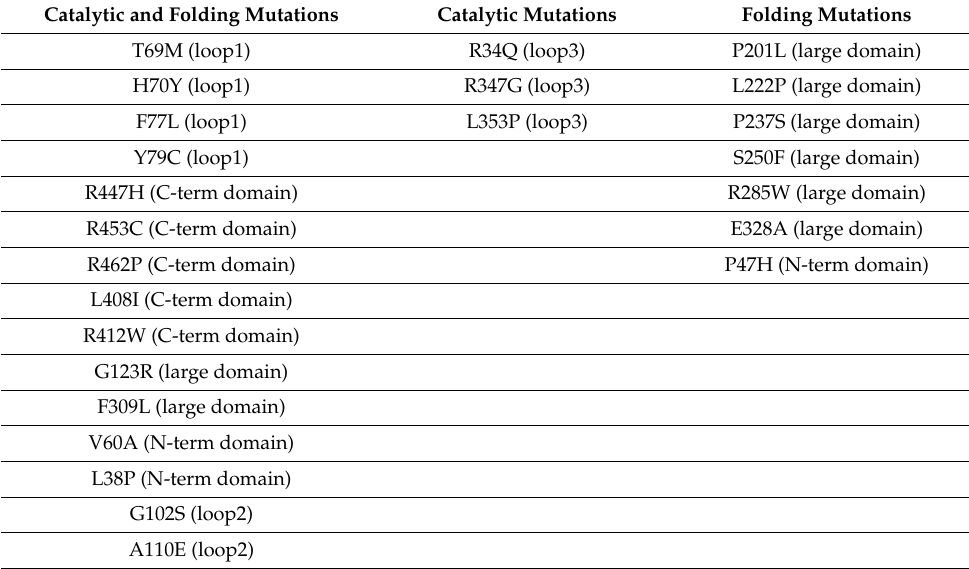
Table 2. Classification of pathogenic mutations in